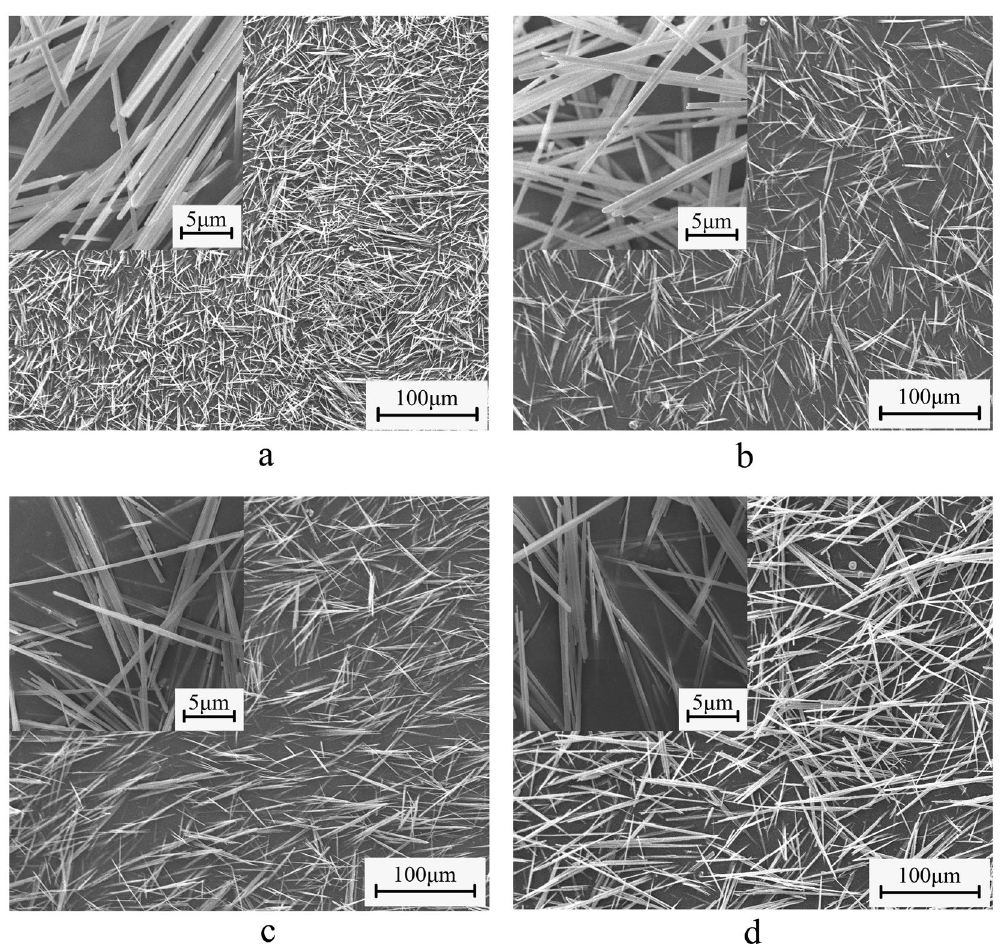
Figure 4. Influence of CTAB on the morphology of α -HH whiskers prepared in glycerol (65 wt%)-water solutions with 5% KCl (by weight of FGD gypsum) at 90 °C for 45 min (( a ) 0; ( b ) 0.05%; ( c ) 0.15%; ( d )